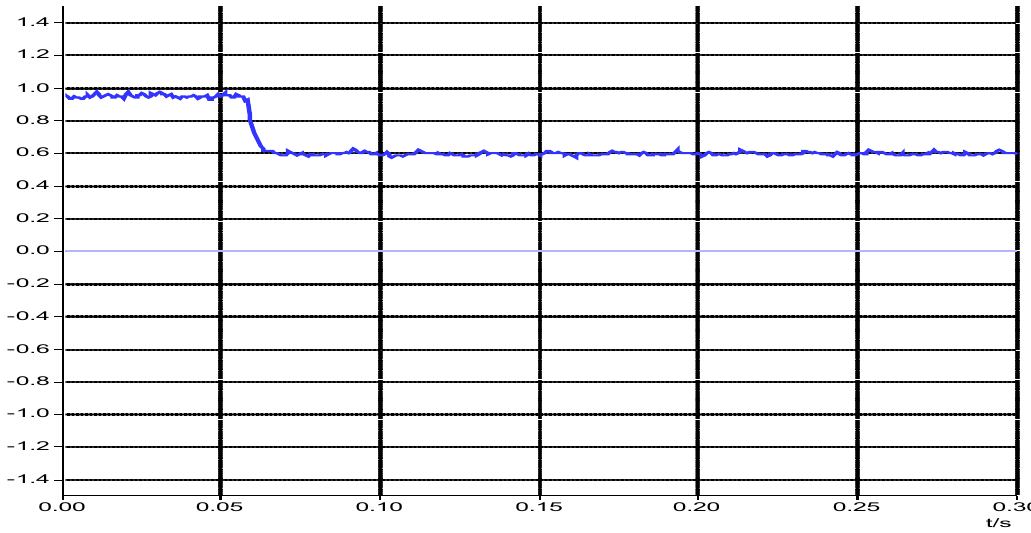
Figure 24. Current in direct axis and quadrature axis (cid:1835) (cid:3034)(cid:3045)(cid:3036)(cid:3031) . Figure 25 shows that the voltages in direct and quadrature axes were zero in the negative sequence before and after a network was subjected to the transient disturbances, even if during a fault creation the voltages swelled and returned to a normal state. These were clearly determined in Equation (25).